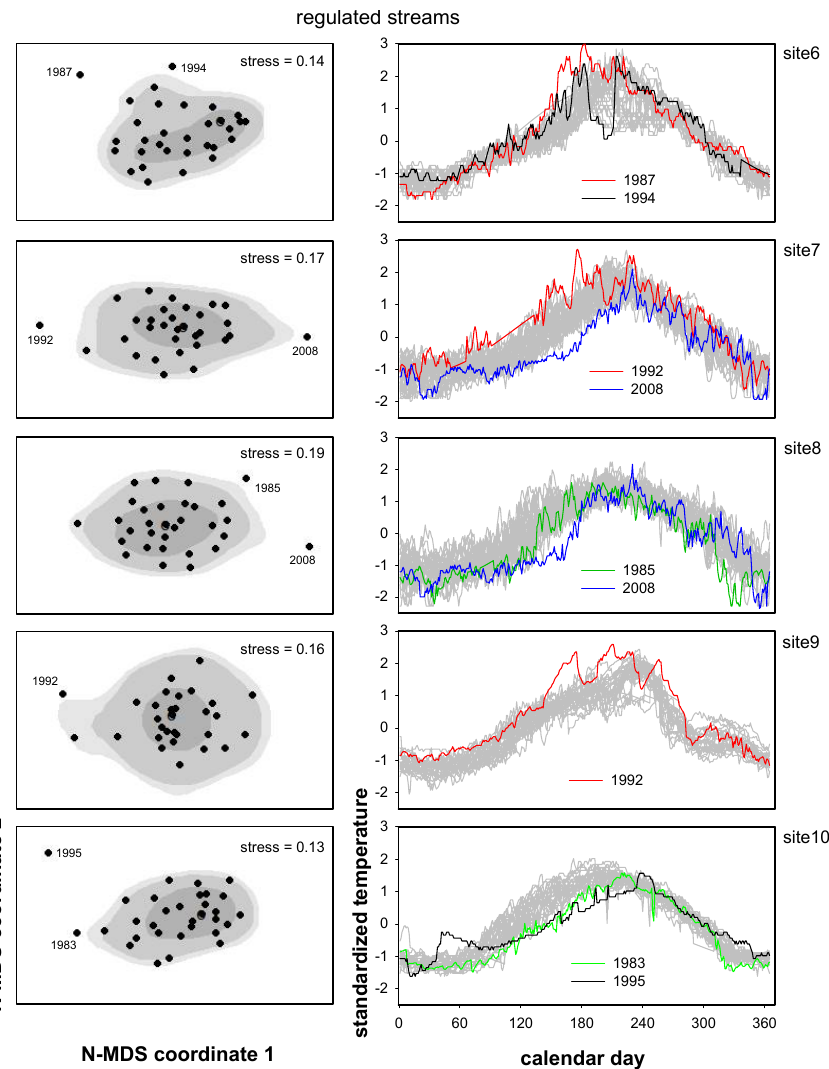
Figure 5. Bivariate HDR boxplots (left panel) and standardized daily temperature distribution (right panel) in regulated streams using annual time series of daily minimum. The dark and light grey regions show the 50, 90, and 95% coverage probabilities. The symbols outside the grey regions and darker lines represent potentially anomalous years. Examples of years between 90 and 95% of the coverage probability were